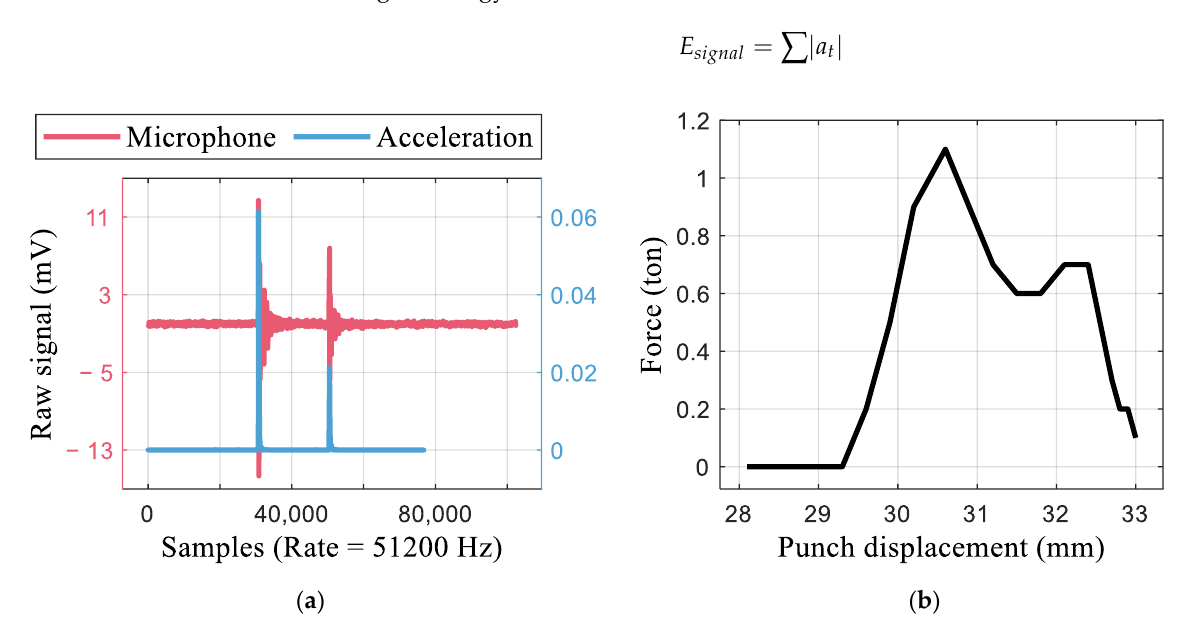
Figure 8. Example signal of ( a ) microphone and accelerometer and ( b ) force punched by punch with angle.